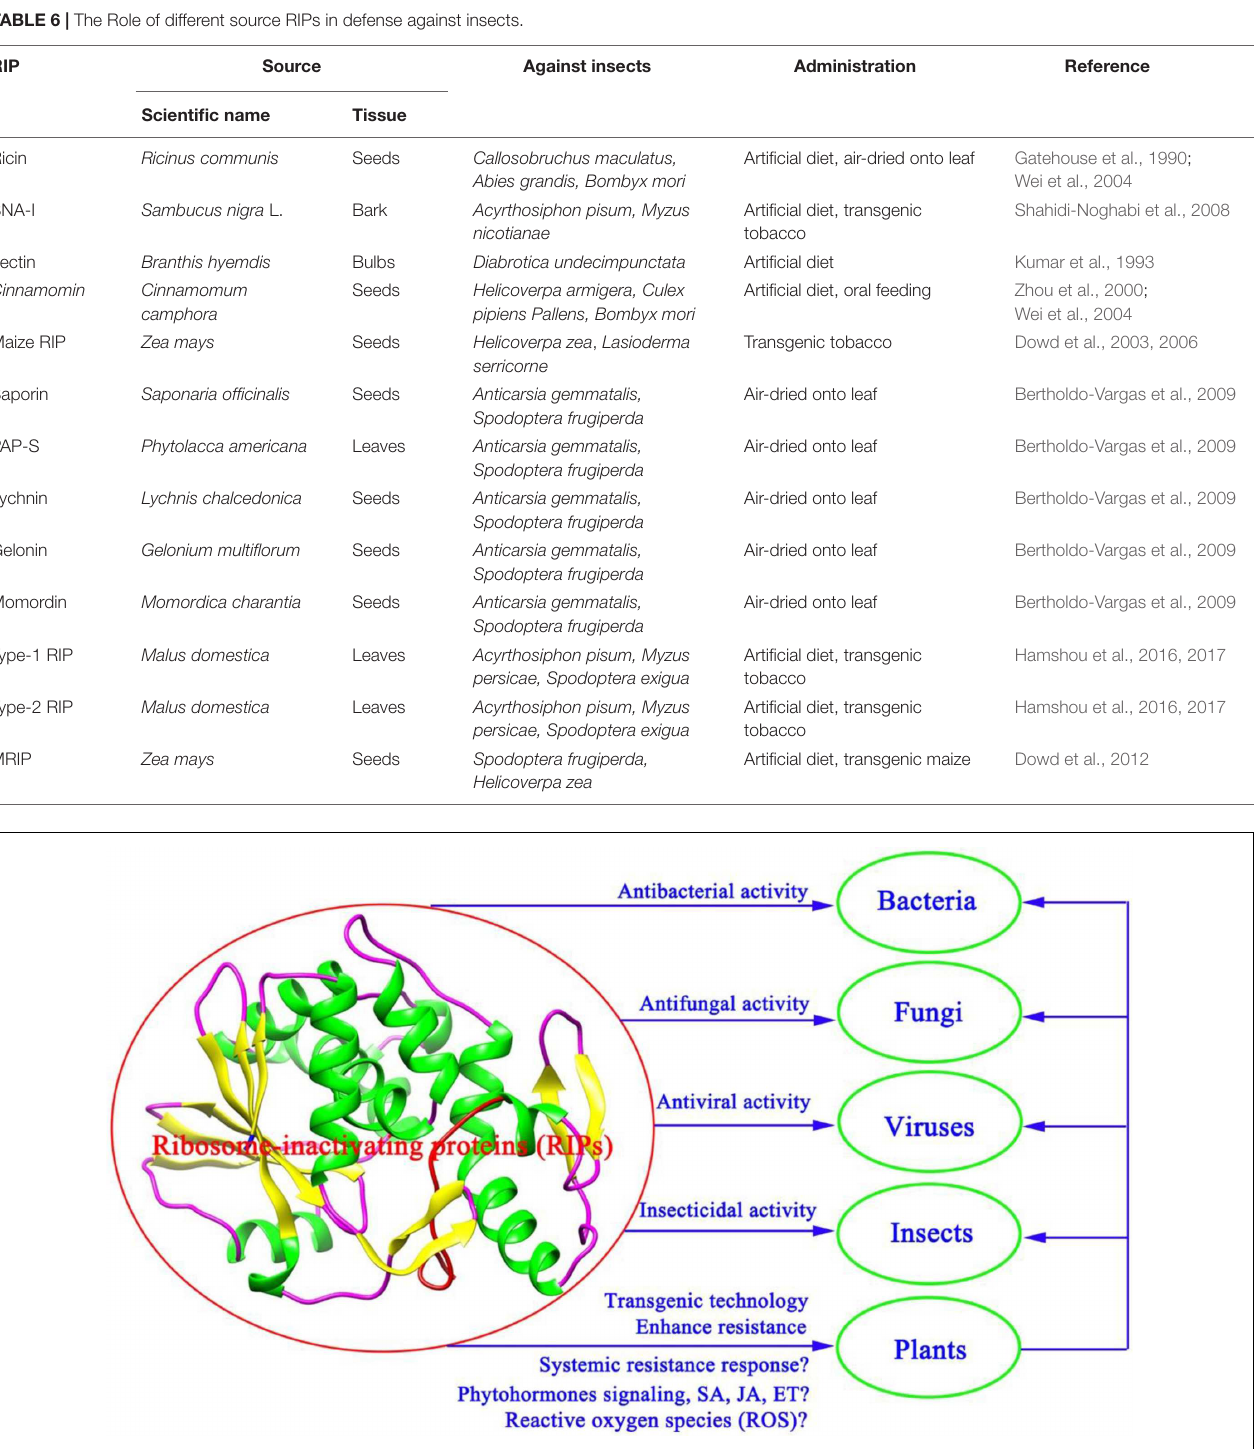
FIGURE 2 | A proposed model for the role of RIPs in defense against pathogens and insects.